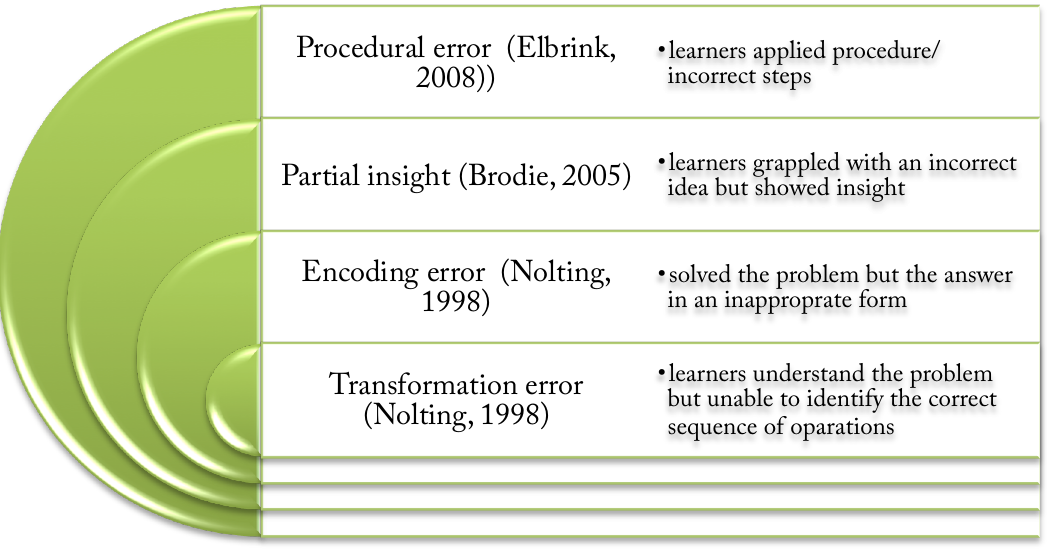
Figure 1: Identified types of errors related to incorrect association and rigidity of